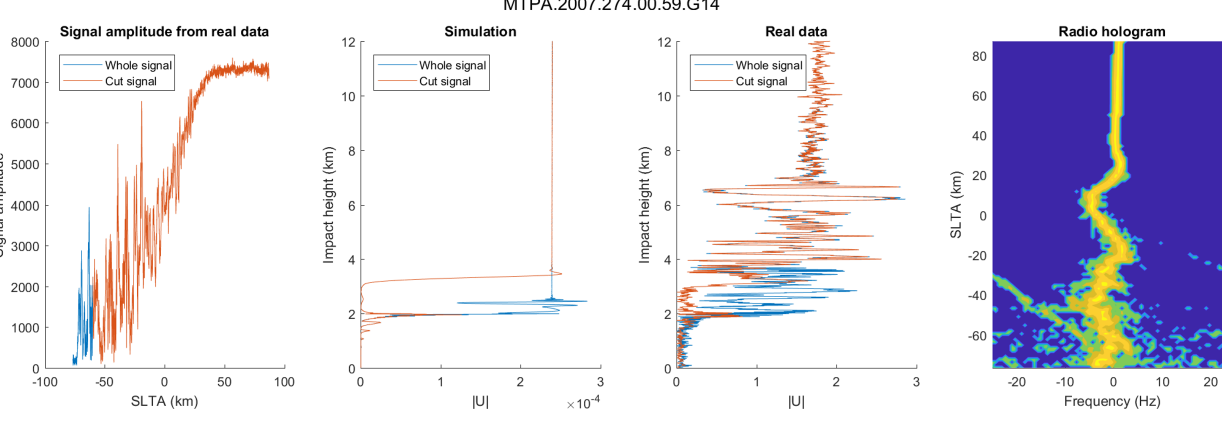
Figure 4. An event classified as category 1. SLTA min is at approximately − 73km, and the signal is truncated at SLTA = − 60km. The reflection spike is 1881m, and a min is